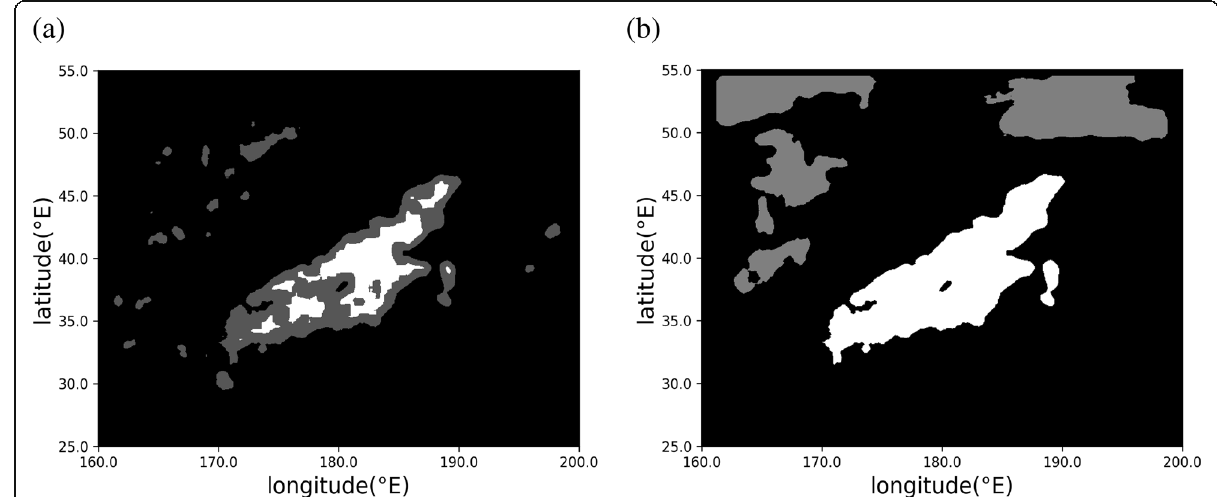
Fig. 5 Results of the segmentation using the proposed method. a A trinarized image of dust derived from Fig. 2b using a single threshold value. The white region is the positive region when using the larger threshold value, p L . The gray regions including the white one are positive regions when using the smaller threshold value, p S . b A trinarized image of dust (white) and WIC (gray) derived from Fig. 2b and e using the combination of two threshold values. p L and p S are 0.95 and 0.5, respectively